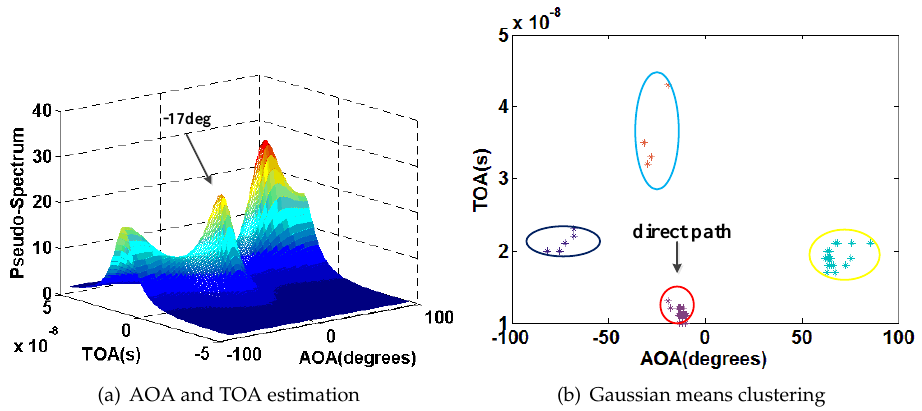
Figure 18. Results of AOA and TOA estimation and the related Gaussian means clustering at the AP4.